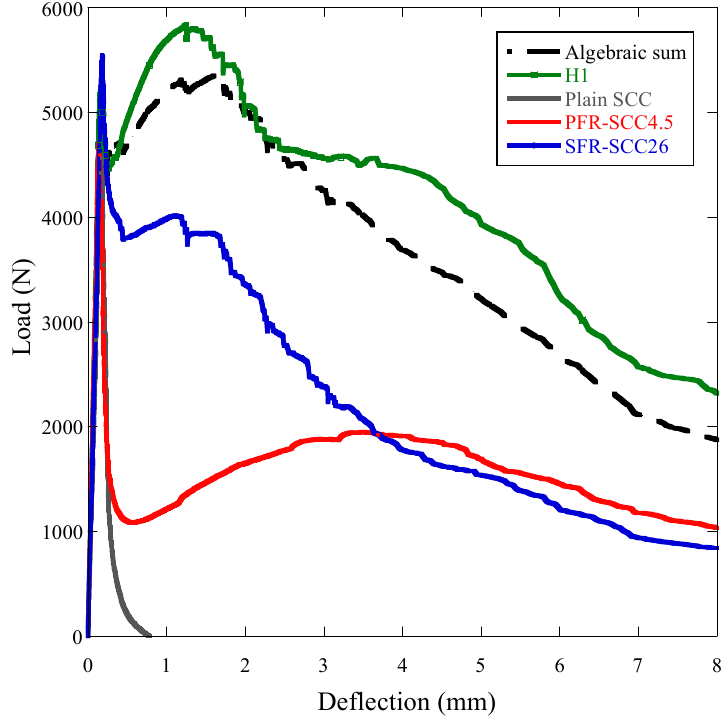
Figure 15. Fracture results of H1 and the sum of the residual contributions of mono-fiber reinforced